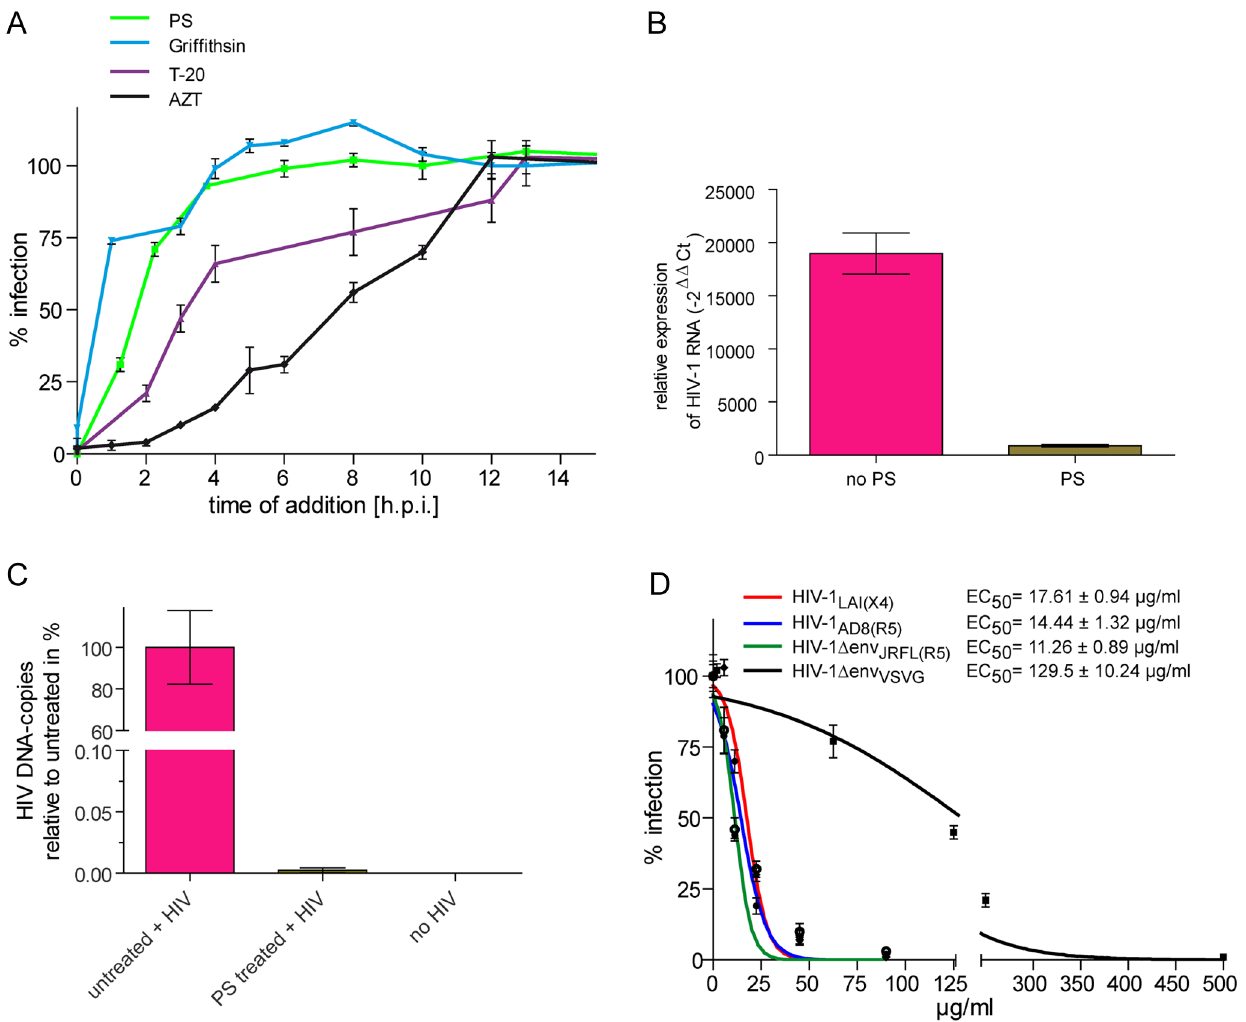
Figure 2. PS extracts inhibit entry of HIV-1 into the host cell. A , Comparison of time-of-addition (TOA) profiles of PS extract and reference compounds that inhibit HIV-1 entry (i.e. Griffithsin and T-20) and reverse transcription (AZT), respectively. For TOA assays, virus preparations (HIV-1 LAI ) were added to LC5-RIC cells and HIV-1 inhibitors added either simultaneously with the virus (time point 0) or at later time points (h.p.i. = hours post infection) at concentrations yielding maximum inhibition (i.e. . 5 6 EC 50 ). Cultures were assayed for reporter expression 48 hours after virus addition and fluorescent signal intensities normalized to those of cultures exposed to virus in the absence of inhibitors. Each time point was measured in triplicate. Mean values and standard deviation of the mean are indicated for each time point. B , Reduction of input HIV-1 viral RNA levels by treatment with PS-extract. LC5-CD4 cells were exposed to HIV-1 LA1 and Efavirenz in the presence or absence of PS extract (50 m g/ml) in triplicate samples. After 4 hours exposure time, RNA was isolated from each sample, cDNA prepared and real-time PCR performed with HIV-1 specific primers to quantify viral RNA levels. HIV-1 transcript levels were normalized to RPII. Relative expression was calculated by the 2 2 2 DD CT method. The data is expressed as fold expression of HIV-1 RNA in HIV-1 exposed/treated samples compared to unexposed/untreated samples. Columns indicate mean values and error bars the standard deviations of the means. C , Reduction of HIV-1 DNA loads in HIV-1-exposed PBMCs by treatment with PS extract. HIV-1 DNA levels were determined by real-time PCR in peripheral blood derived mononuclear cells treated with PS extract during exposure to HIV-1 and in untreated infected cells (analysed in triplicate samples). Columns indicate mean values and error bars the standard deviations of the means. D , Influence of envelope proteins on the inhibition of virus infection by PS extract. LC5-RIC cells were exposed to HIV-1 variants with different HIV-1 envelope proteins representing different virus tropisms (HIV-1 LAI : X4-tropic; HIV-1-AD-8 and HIV-1 D Env JRFL(R5) : R5-tropic) or HIV-1 based virus particles pseudotyped with an envelope protein (G-protein) from a heterologous virus ( Vesicular Stomatitis Virus ; HIV-1 D Env VSVG ) in the presence of different concentrations of PS extract. Cultures were assayed for reporter expression 48 hours after virus addition and fluorescent signal intensities normalized to those of cultures exposed to virus without inhibitors. Mean values of triplicate wells and standard deviation of the mean are indicated for each extract concentration.